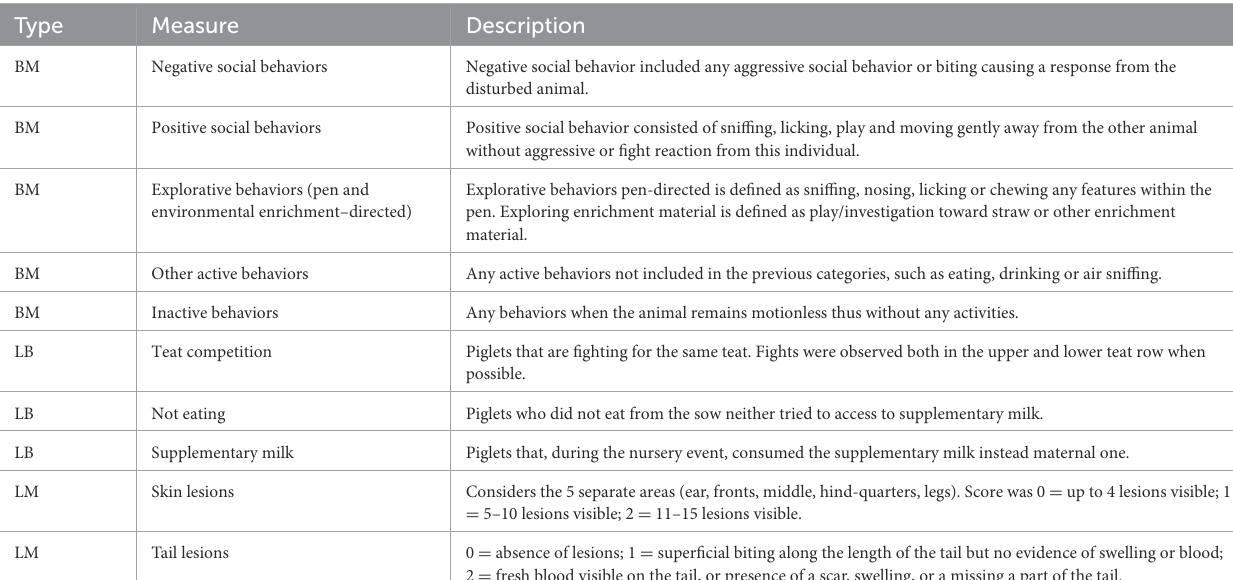
TABLE 4 Animal-based